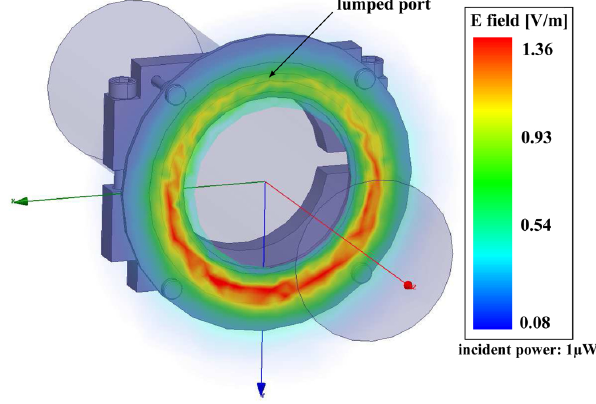
Figure 7. Simulated electrical field at 3mm from the receiving ca- pacitive coupler element surface.